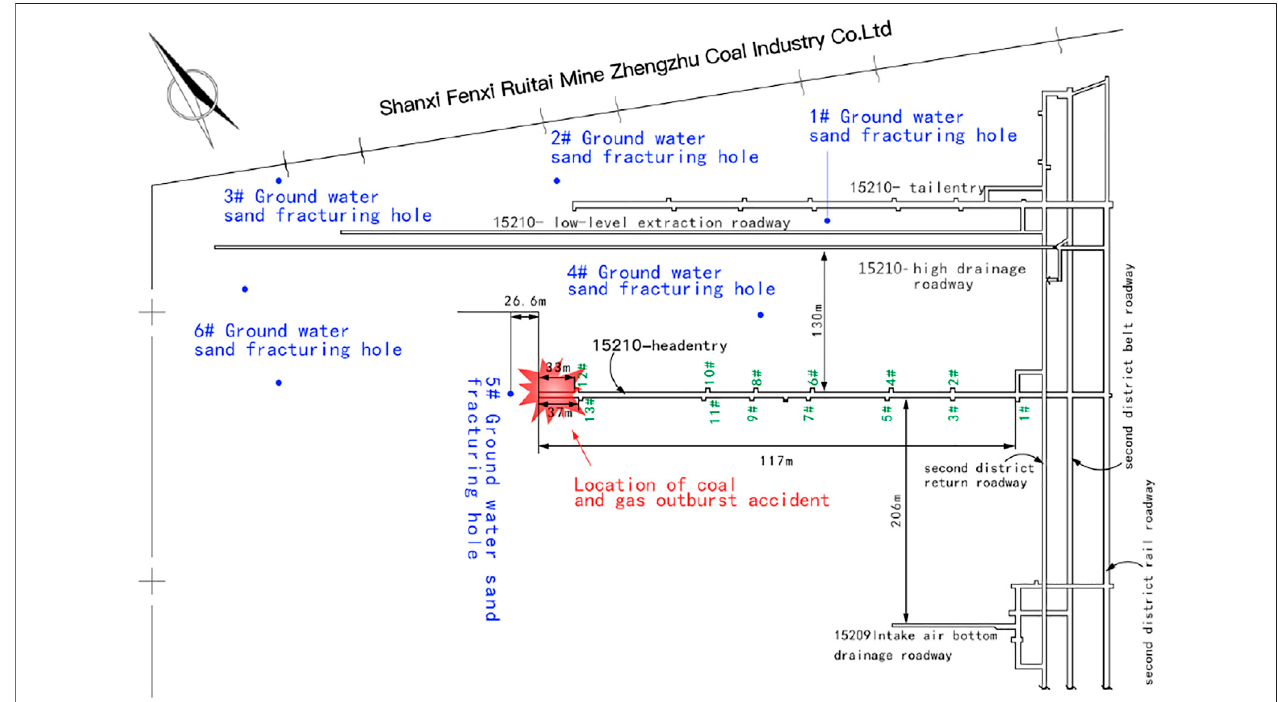
FIGURE 5 | Layout of coal and gas outburst accident